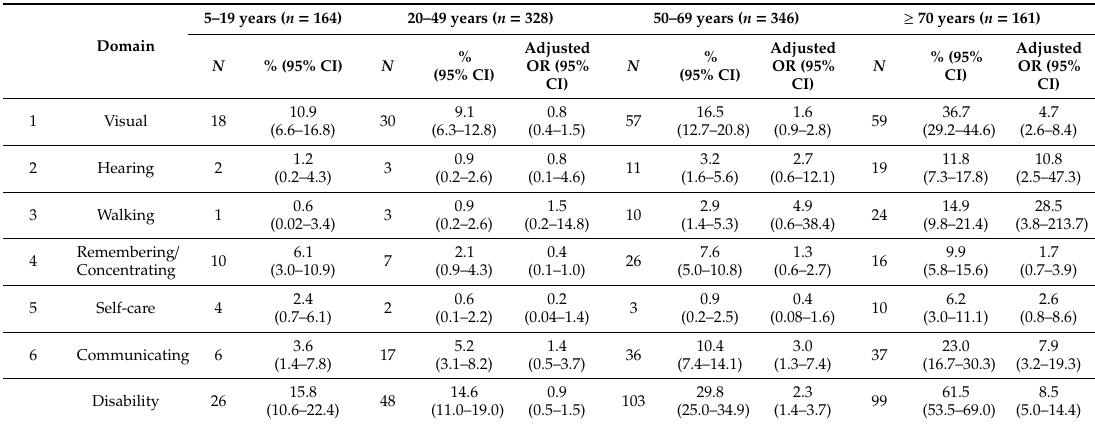
Table 4. Age-disaggregated rates of six Washington Group functions and disability.